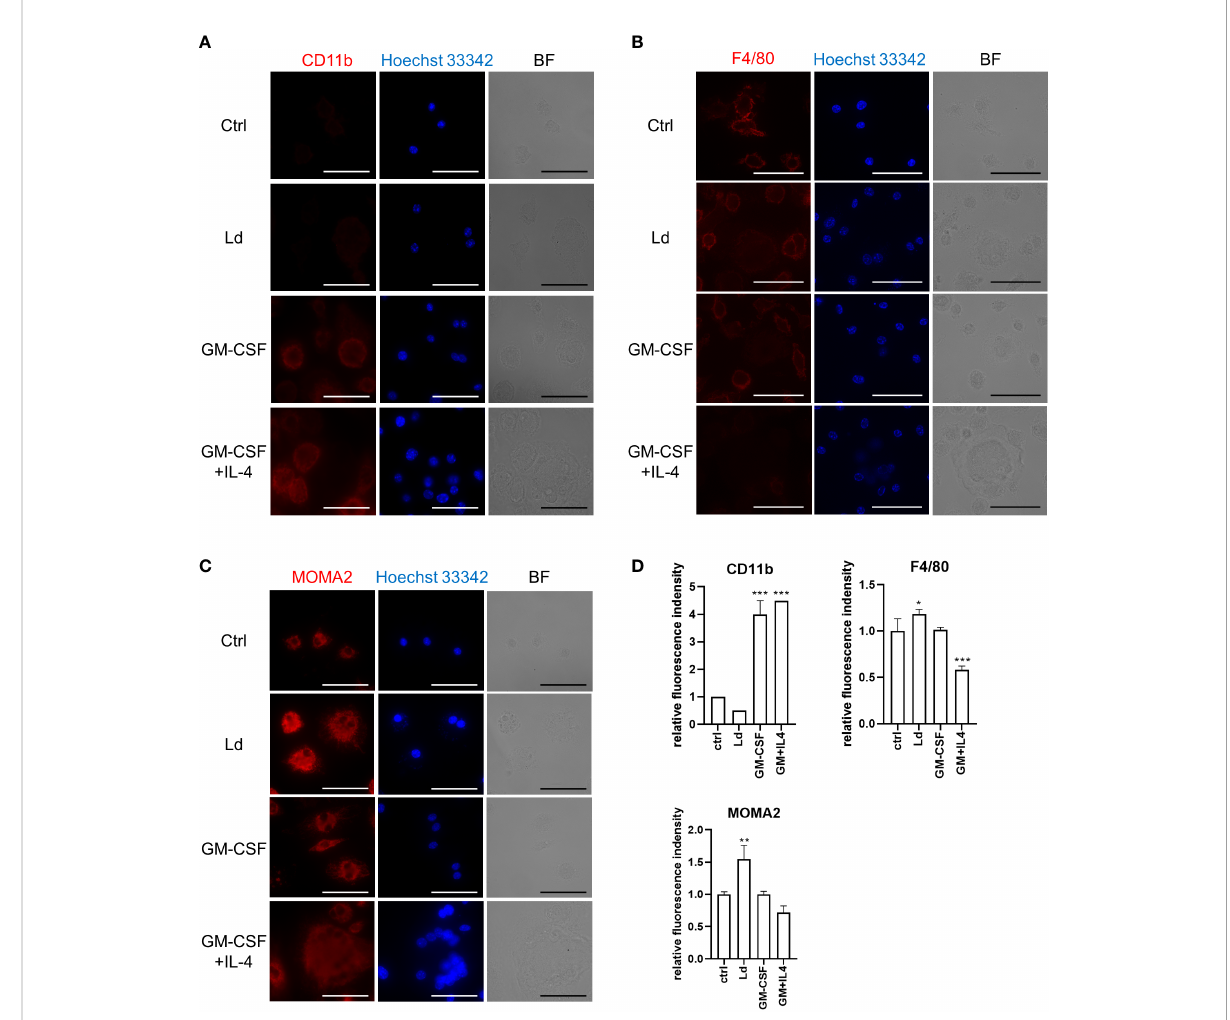
FIGURE 3 Leishmania donovani -induced MGCs have MOMA2 high CD11b low feature. BMDMs were cultivated on eight-well chamber slides and stimulated with GM-CSF or GM-CSF + IL-4 or infected with L. donovani . Cells were fi xed/permeabilized at 72 h after stimulation and stained for CD11b. BF, bright fi eld (A) , F4/80 (B) , and MOMA2 (C) . Representative photosof two independent experiments areshown. Bars, 50 m m. (D) Fluorescence density ofCD11b, F4/80,and MOMA2 per cell. Means + SD ofover 20 cells in each group areshown. * P < 0.05, ** P < 0.01, *** P < 0.001vs. the control group by one-way ANOVA followed by Dunnett ’ s multiplecomparisons